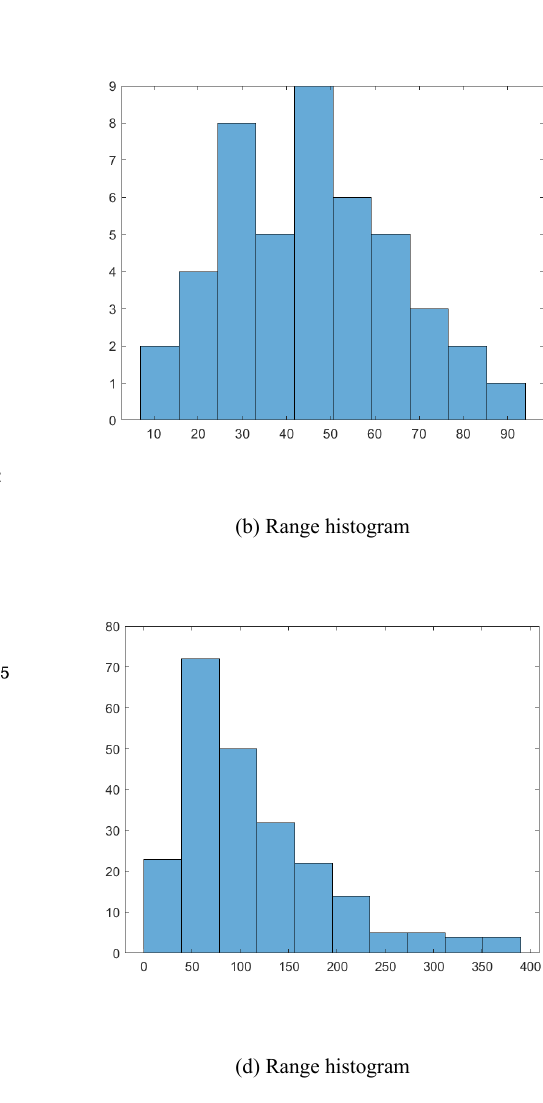
Figure 4 . Relationship between spatial distribution of points and range